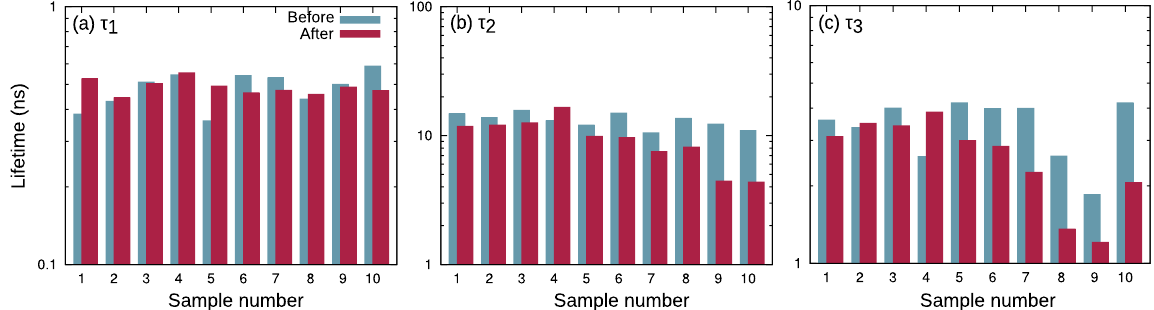
Figure 5. InGaP subcell PL decay time constants: ( a ) τ 1 , ( b ) τ 2 , and ( c ) τ 3 . Blue and red bars represent values before and after electron irradiation, respectively.